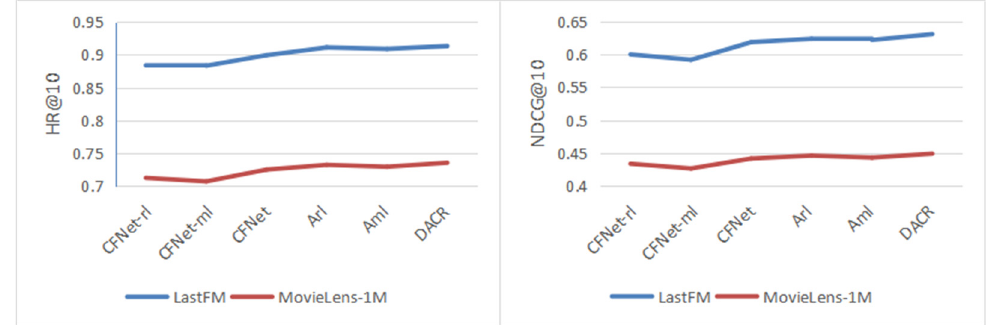
Figure 4. The impact of different modules on recommendation results on LastFM and MovieLens-1M.